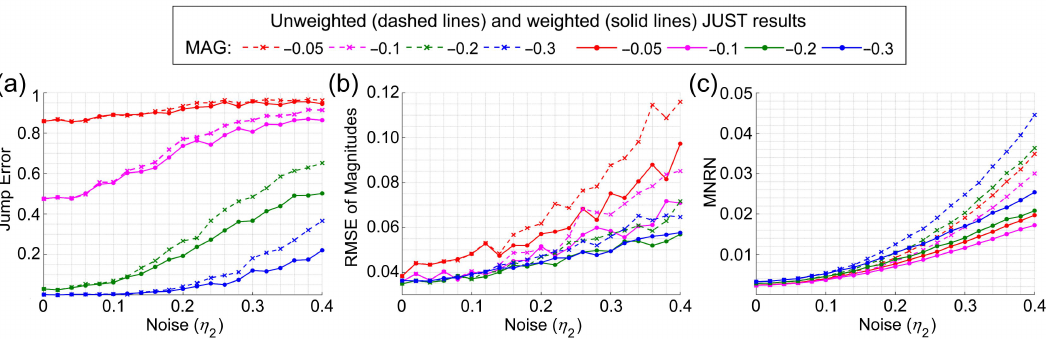
Figure 8. Statistical results for the ( a ) detection of true jumps, ( b ) magnitudes of the true jumps, and ( c ) residual series using the unweighted and weighted JUST shown by dashed and solid lines, respectively. The initial η 1 noise level is 0.1. These results are for a collection of 1000 unequally spaced two-year-long time series per each noise level, one of such time series is illustrated in Figure 7e.